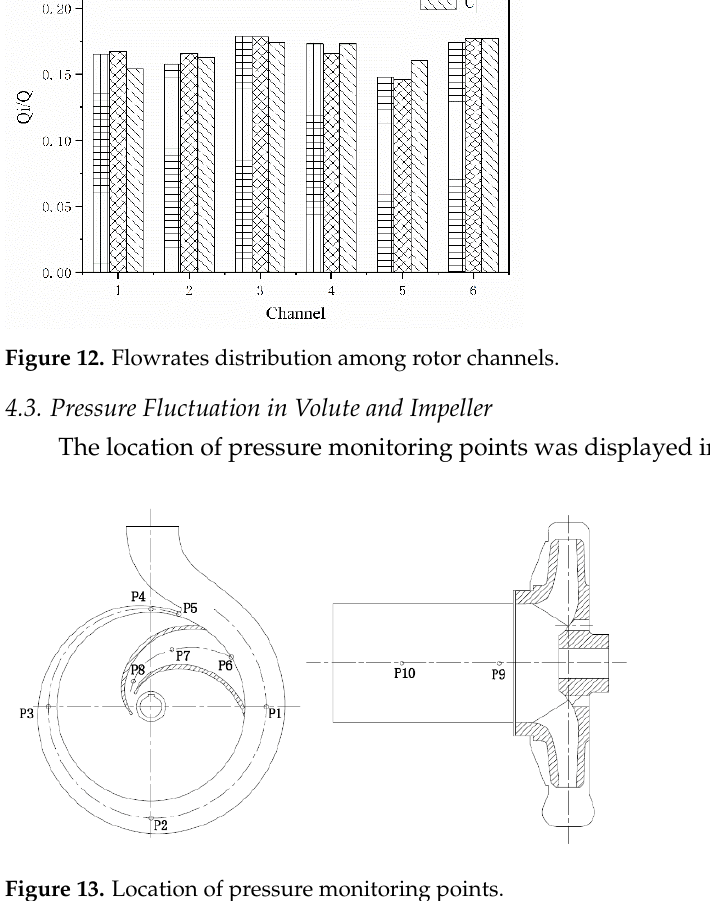
Figure 11. The circumferential pressure decreases in the rotor channel.